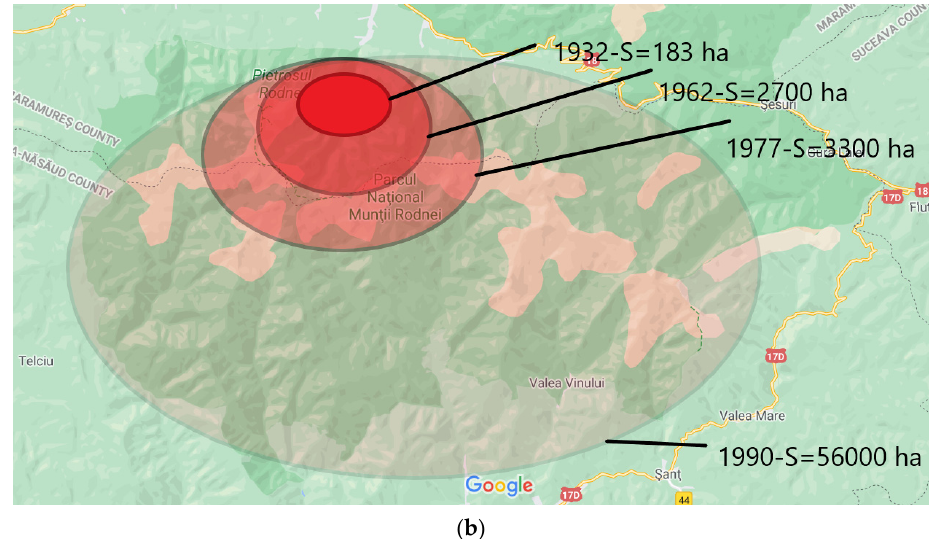
Figure 1. ( a ) The Location of the Rodna Mountains National Park. ( b ) The Development of the Rodna Mountains National Park. Source: [24].